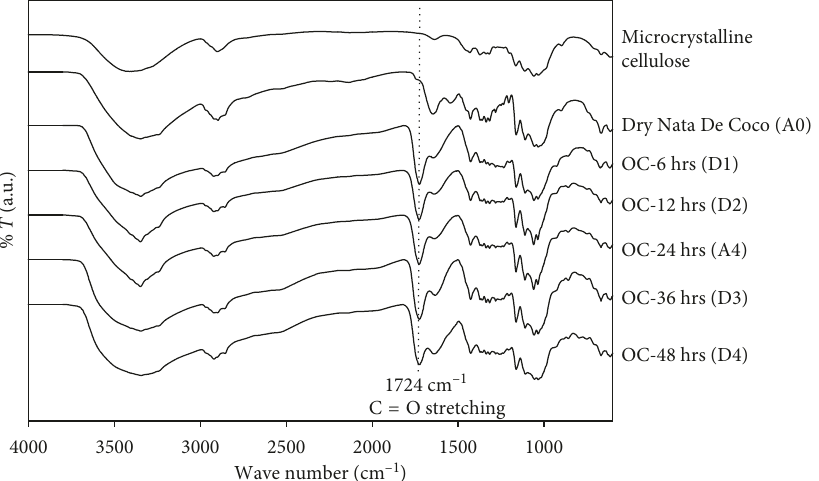
Figure 7: FT-IR spectra of microcrystalline cellulose, DNDC (A0), and the OC